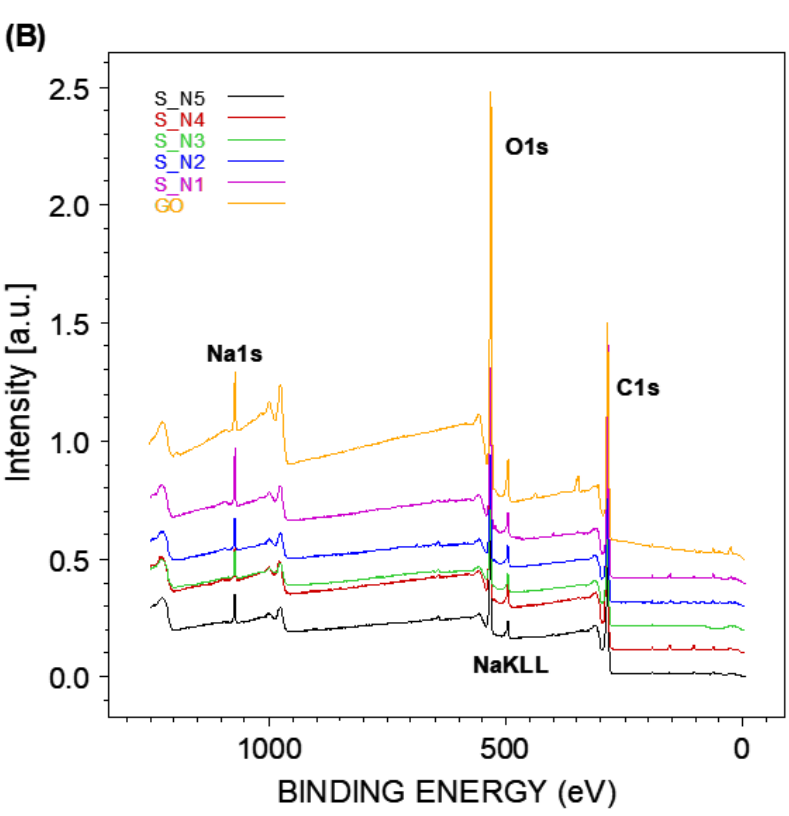
Figure 1. ( A ) Wide spectra of rGO samples synthesized using HI at increasing concentrations. The wide spectrum of GO is plotted as a reference. ( B ) Wide spectra of rGO samples synthesized using NaBH 4 at increasing concentrations. All the spectra are normalized to the C 1s intensities to highlight O 1s variations and shifted along the Y axis to better show the spectral features. The main spectral components are indicated in both figures.